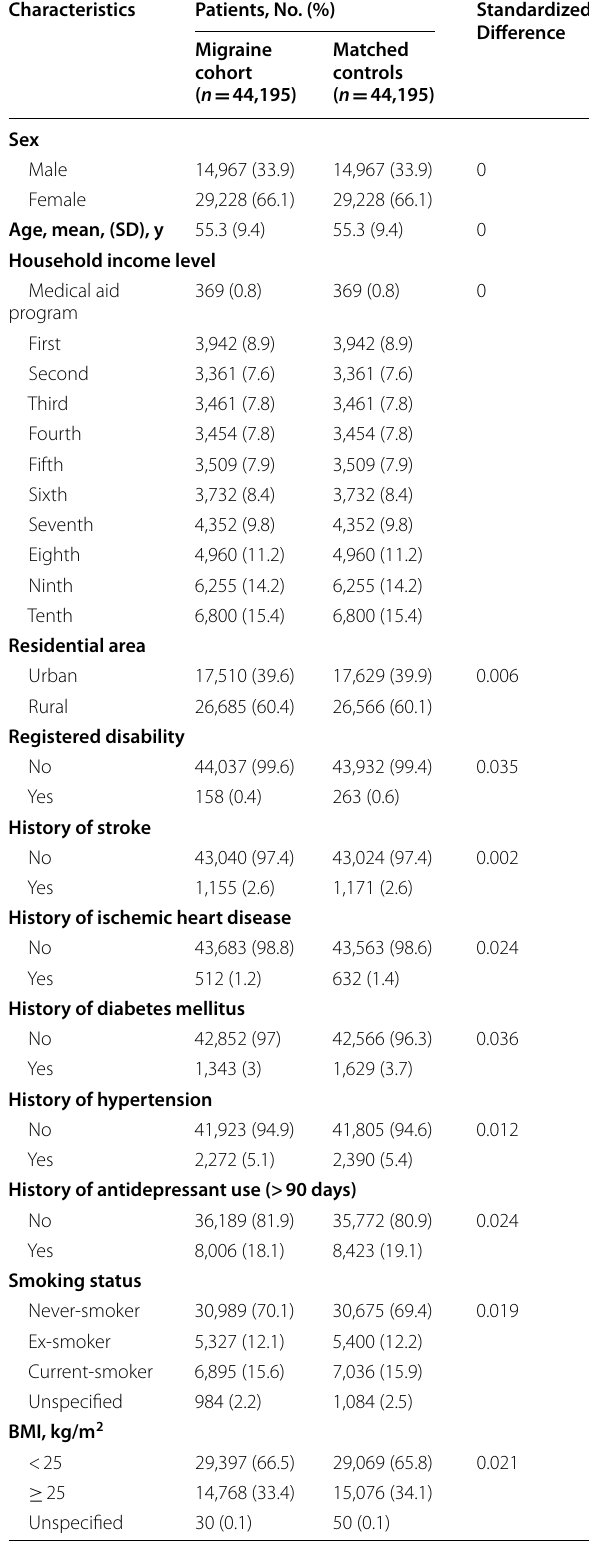
Table 1 Baseline characteristics of the study population